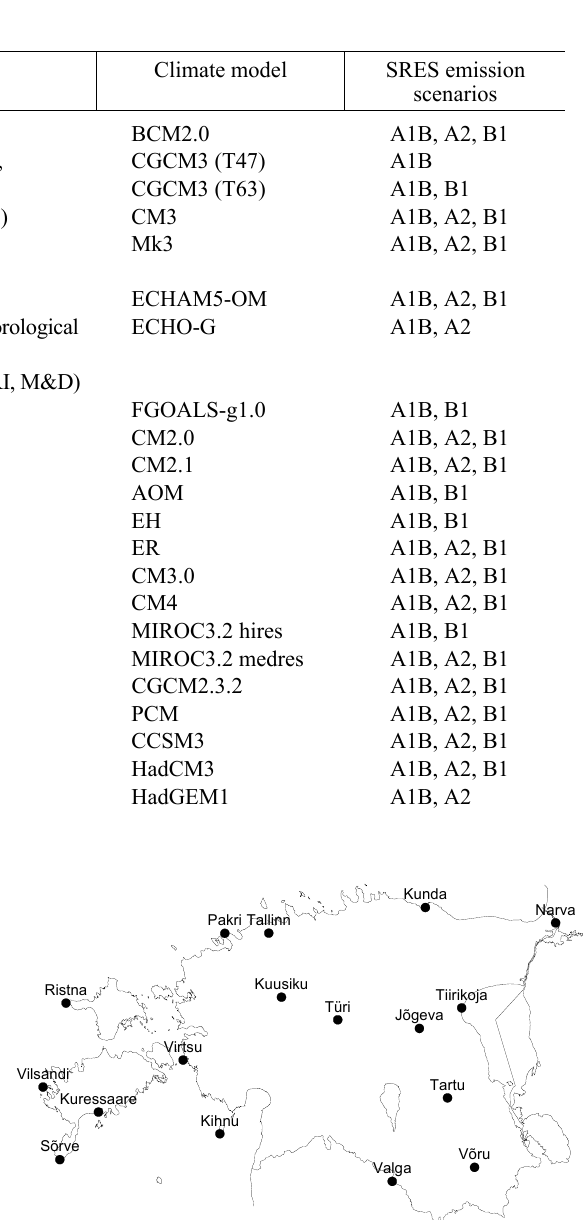
Table 1. General circulation model outputs from AR4 with different SRES emission scenarios available on the IPCC